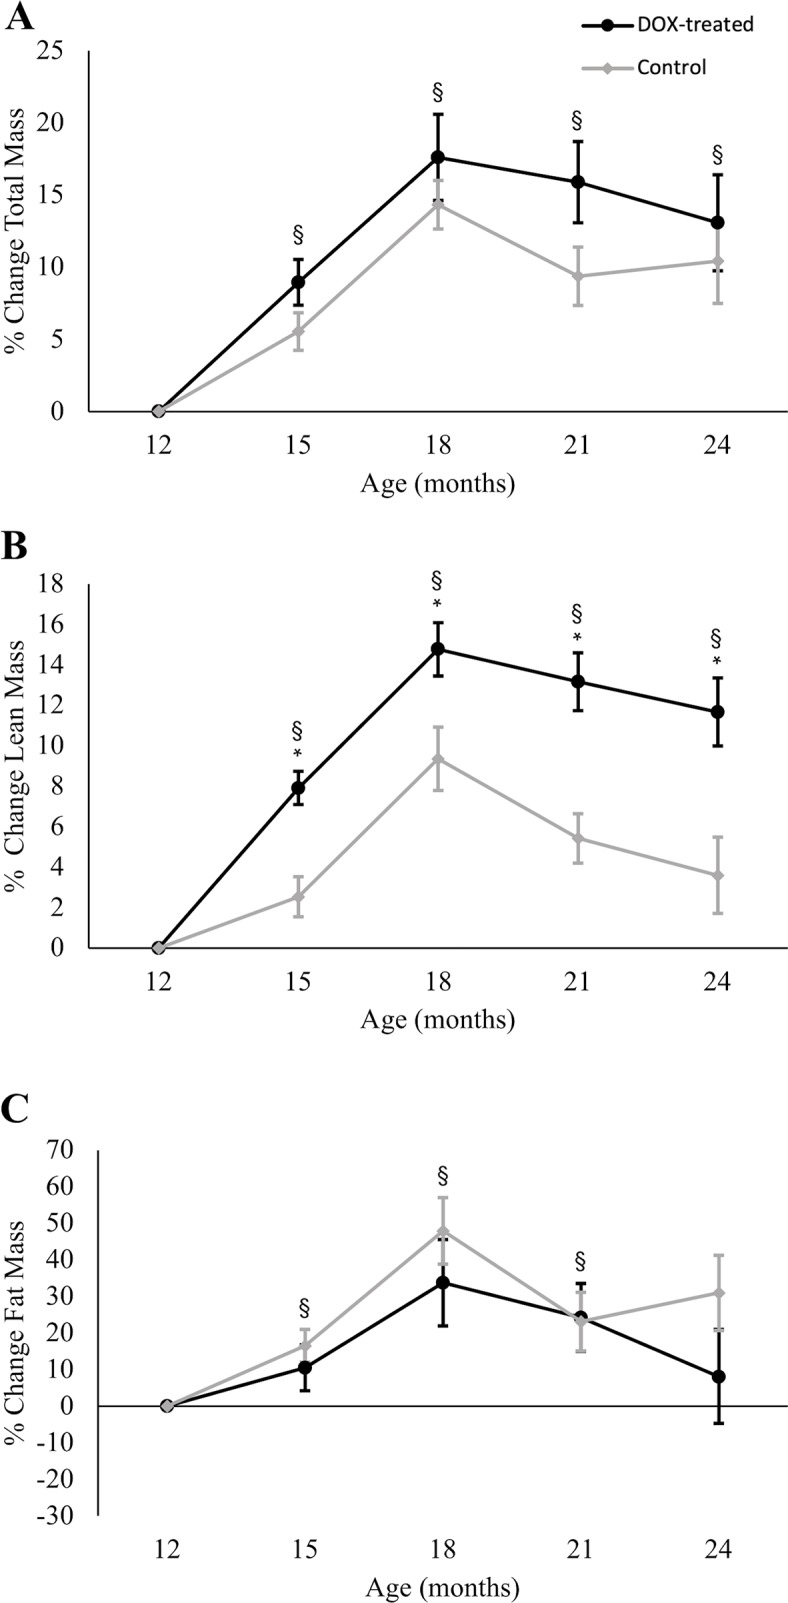
Changes in total, lean, and fat mass in treated and control female mice.(A) Compared to 12-month baseline, total body mass was significantly higher at all time points in the female group, and DOX treatment had no significant effect. (B) Lean mass was also significantly higher from 12-month baseline at all time points in the female, but more pronounced in DOX-treated females, a statistically significant difference compared to the control group. (C) Fat mass was significantly higher than 12-month baseline at 15, 18 and 21 months, and there was no effect of DOX treatment. To show the main effect of time, DOX-treated and control values were pooled and the comparison to baseline indicated with § (p < 0.05); the asterisk (*) indicates significant difference between DOX-treated and control mice at specified time points (p < 0.05). Values are mean ± SEM.